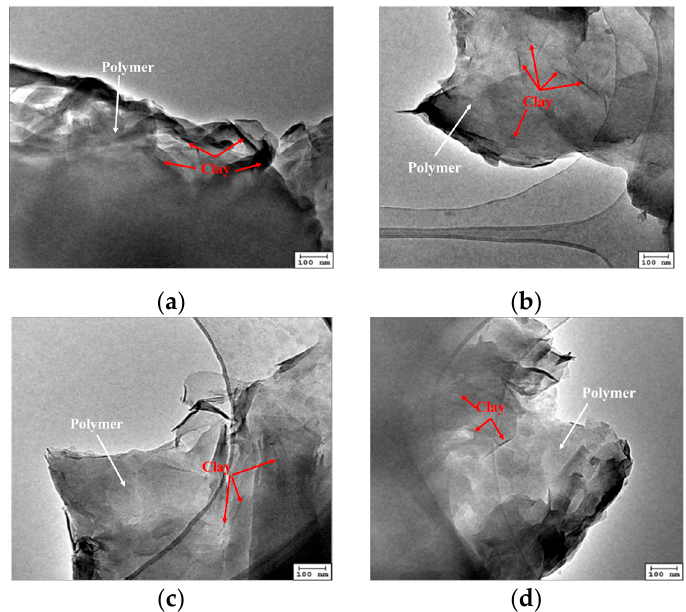
Figure 4. TEM images of the intercalated polymer synthesized under different initiation temperatures: ( a ) 8 °C; ( b ) 10 °C; ( c ) 11 °C; ( d ) 15 °C.